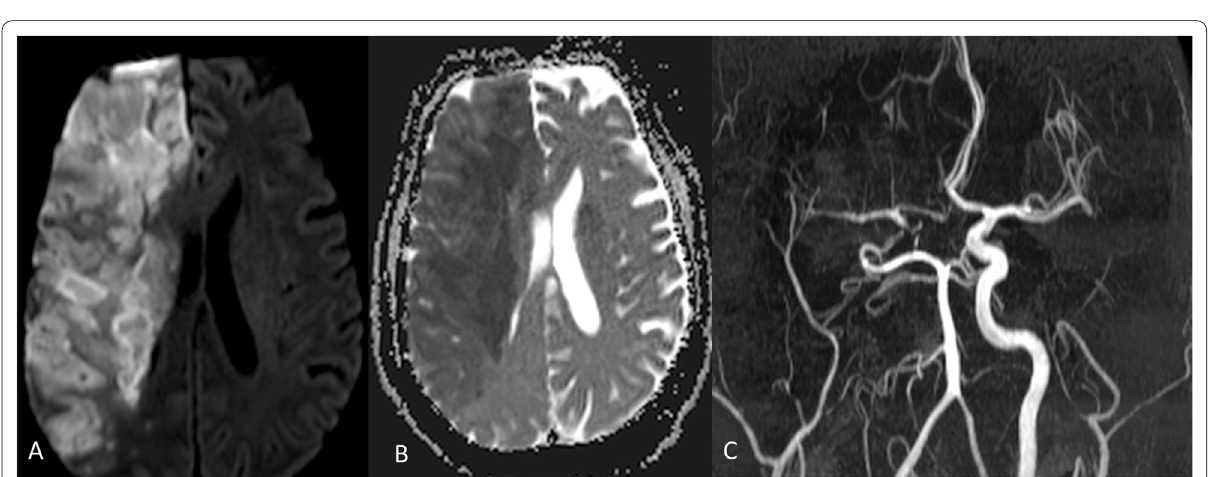
Fig. 10 A (DWI) and B (ADC) images show acute infarct in right internal artery territory. C (MR angiography thick slab image): There is non-visualization of right internal carotid artery. Carotid Doppler (not shown) revealed a thrombus in proximal right internal carotid artery. Right middle cerebral artery is seen to be partly reformed by collaterals